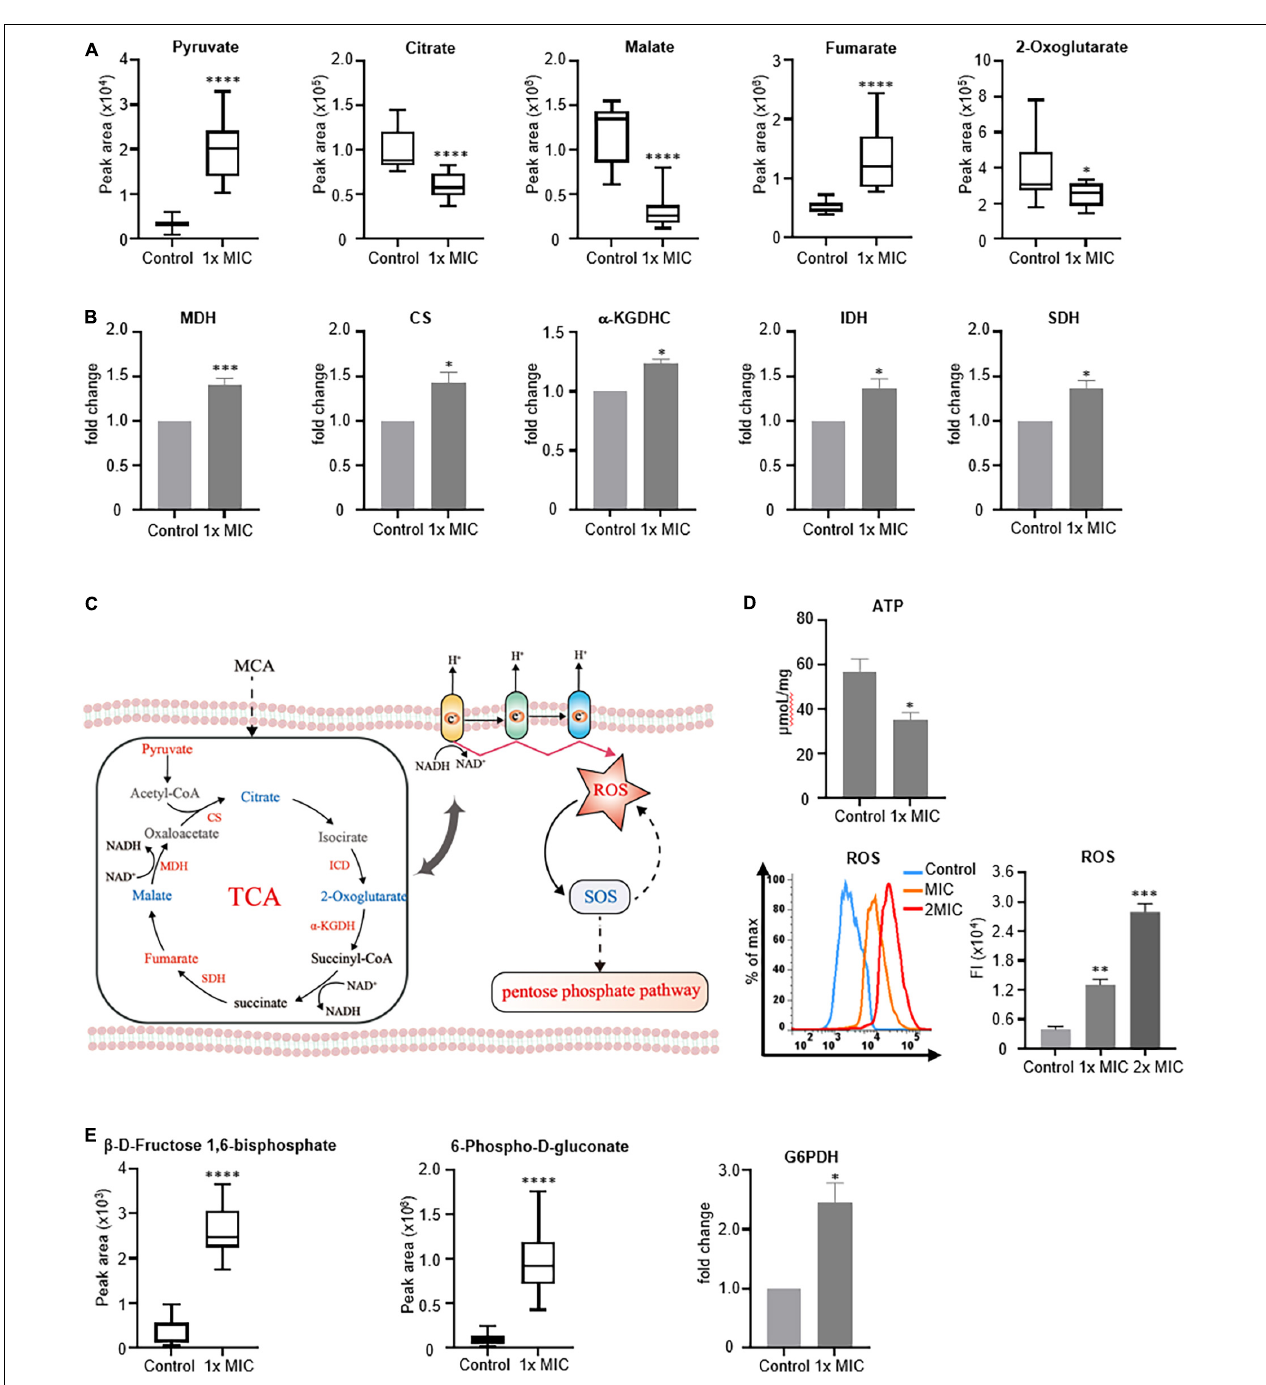
FIGURE 6 | MCA treatment increased metabolic flux through the TCA cycle and the intracellular ROS. MRSE in the logarithmic growth phase was treated with MCA at 1 × MIC for 6 h, and 0.1% ethanol was used as the vehicle control. (A) Peak areas of key metabolites in the TCA cycle of control and MCA group. The peak areas of indicated metabolites were quantified by GC-MS-based metabolomics. (B) Activities of key enzymes catalyzed the irreversible steps of the TCA cycle. After treatment, cell pellets were lysed, and the activities of enzymes were analyzed by ELISA kits. After normalizing the measured activities to the control group, the fold changes were used for quantification. (C) Illustration of connections between TCA and ROS generation. (D) ATP content and ROS level of MRSE. After treatment, the intracellular ATP was quantified by using a chemiluminescence kit, and the intracellular ROS was analyzed by CM-H 2 DCFDA staining. The histogram of fluorescence from flow cytometry was plotted, and the medium fluorescence intensity was used for quantification. (E) Activities of key enzymes involved in the pentose phosphorylation pathway. After treatment, the activities of key enzymes involved in PPP were assayed using the ELISA kit. After normalizing the measured activities to the control group, the fold changes were used for quantification. The pooled data are presented as mean ± SEM of at least three independent experiments. ∗ p < 0.05, ∗∗ p < 0.01, ∗∗∗ p < 0.001, ∗∗∗∗ p < 0.0001.